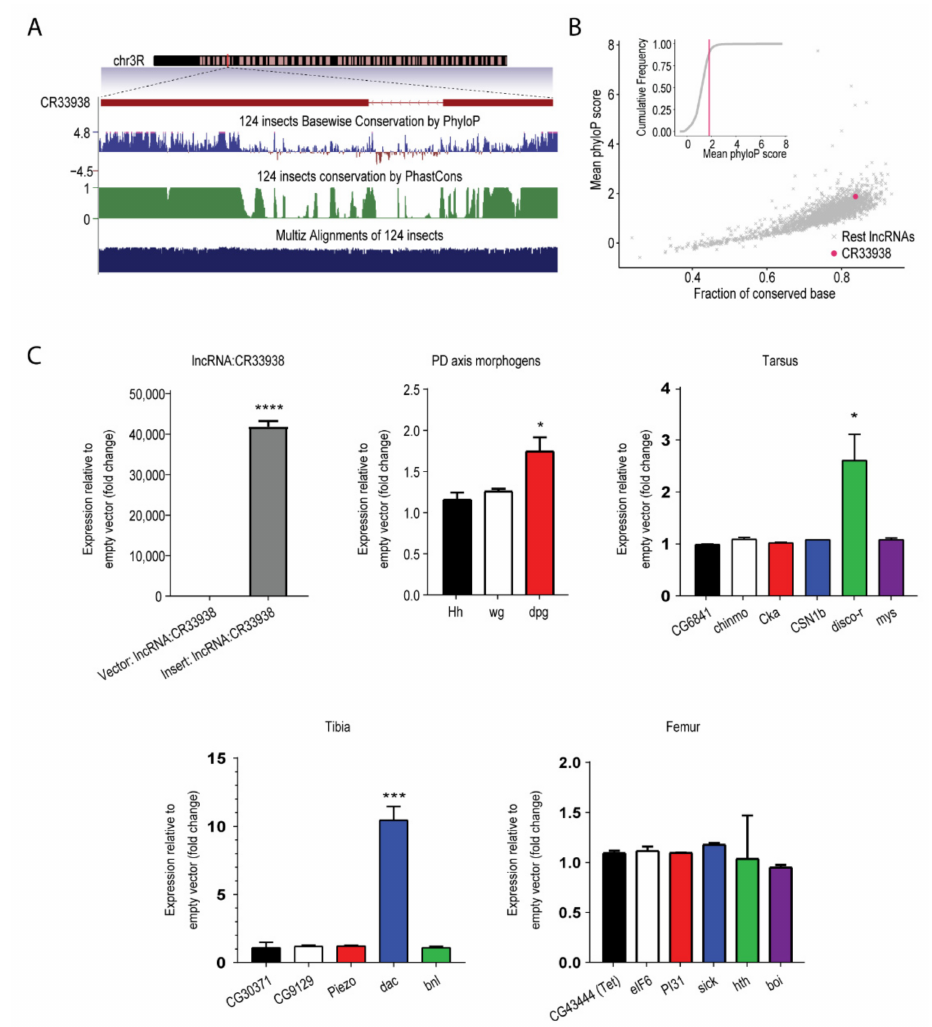
Figure 3. LncRNA:CR33938 is conserved among insects and overexpression in Drosophila S2 cells increased expression levels of genes involved in leg development. ( A ) lncRNA:CR33938 , identified on chromosome 3, is conserved within insects. ( B ) The fraction of conserved bases of lncRNA:CR33938 across insects is greater than 0.8. ( C ) Overexpression of lncRNA:CR33938 in S2 cells produced an increase in the expression of leg development genes, including PD axis genes, distal leg tarsal disco- r , and medial leg tibial dac according to qPCR. There was no effect on proximal leg femur genes. *, ***, **** equate to p -values of less than 0.05, 0.001 and 0.0001,